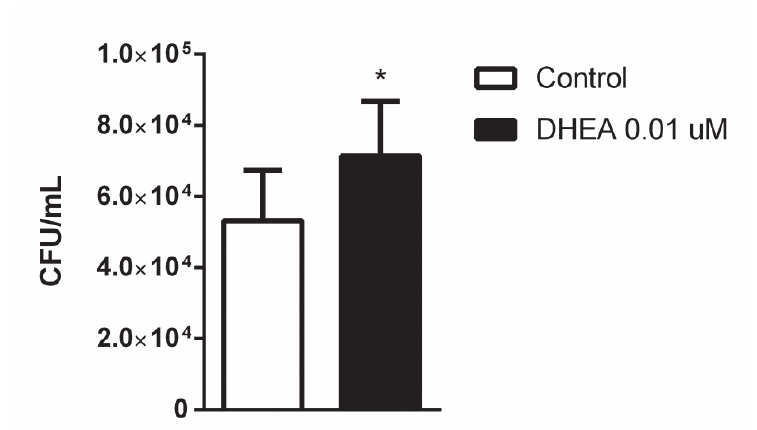
FIGURE 2 – Phagocytosis by neutrophils infected with S. Typhimurium is increased by DHEA treatment. Neutrophils isolated from healthy men were treated in vitro with 0.01 μM of DHEA for 1 hour and then the cells (2 x 105) were infected with S. Typhimurium (MOI=10) for 15 min. Non-phagocytosed bacteria were washed out, and cells were lysed with 0.05% saponin (w/v) to release the intracellular bacteria. The suspension of bacteria was subjected to serial dilutions (1:10), plated in BHI medium and the number of CFU was determined. Data express the Mean (SD) of 8 independent experiments performed on different days, with cells from 11 different donors.